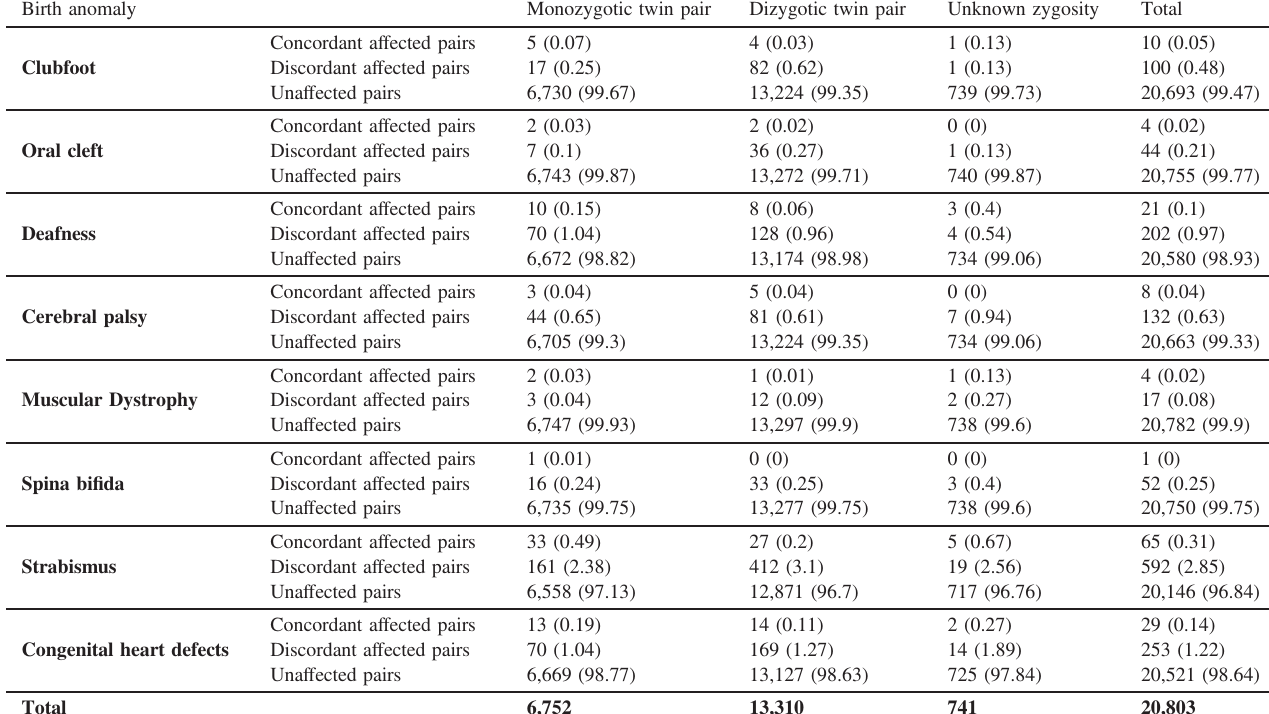
Table 2. Frequency of birth anomalies among 20,803 twin pairs by concordance and zygosity in the California Twin Program (Birth cohort 1957 – 1982)